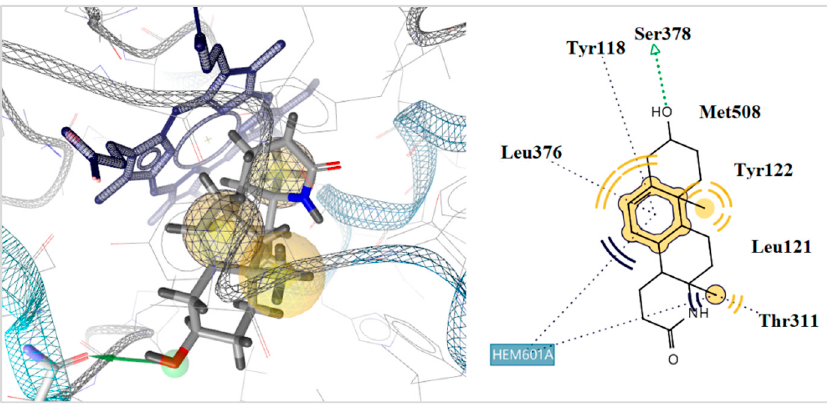
Figure 3. Docked conformation of the compound 28 in lanosterol 14 α -demethylase of C . albicans .